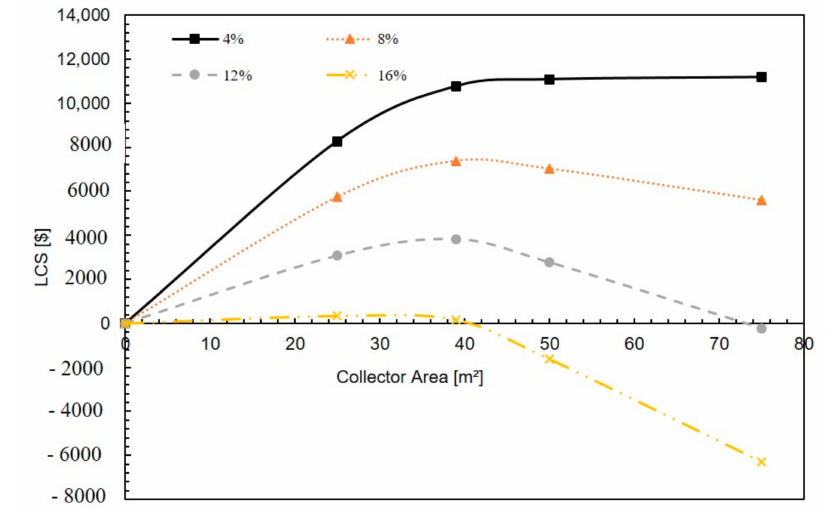
Figure 12. The e ff ect of interest rate on the life-cycle saving at di ff erent collector